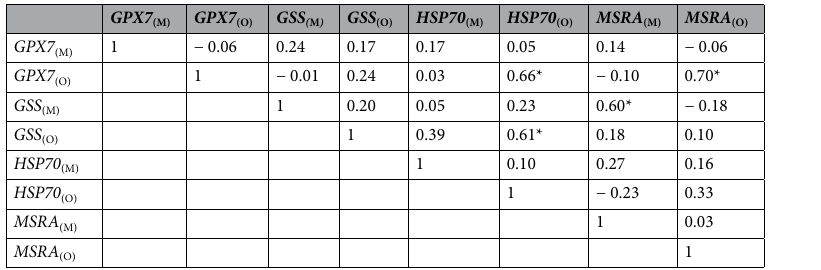
Table 6. Pearson correlation coefficients between the expression of glutathione peroxidase 7 ( GPX7 ), glutathione synthetase ( GSS ), heat-shock protein 70 kDa ( HSP70 ), and methionine sulfoxide reductase A ( MSRA ) genes in quail mothers (M) and their offspring (O). An asterisk (*) indicates a significant correlation ( P <